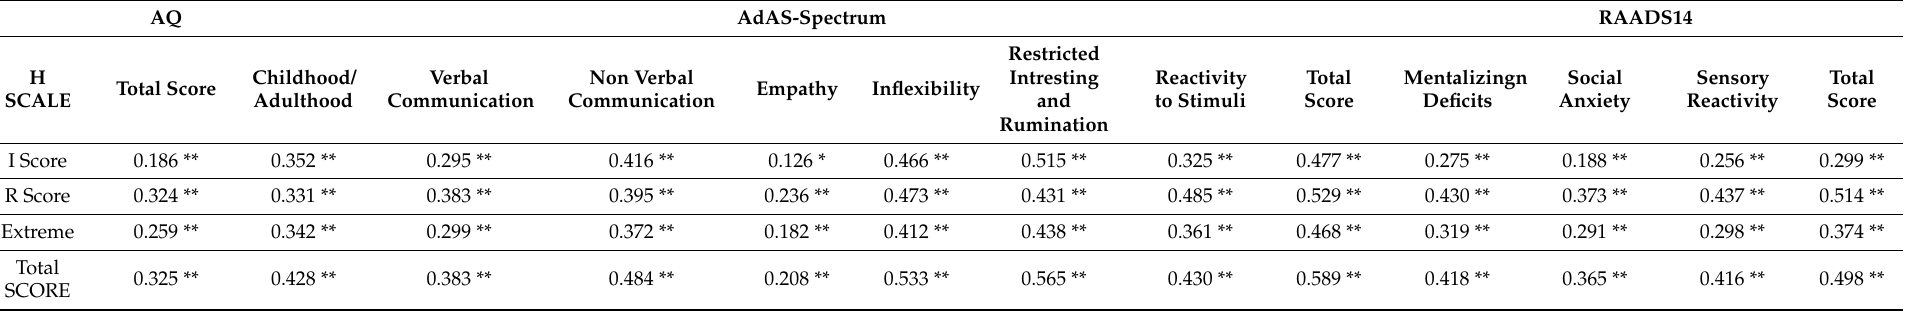
Table 2. Correlation analysis (Pearson correlation) controlled for gender and age between arousal (H-Scale) and autistic traits (AQ, AdAS-Spectrum and RAADS14) in total sample.